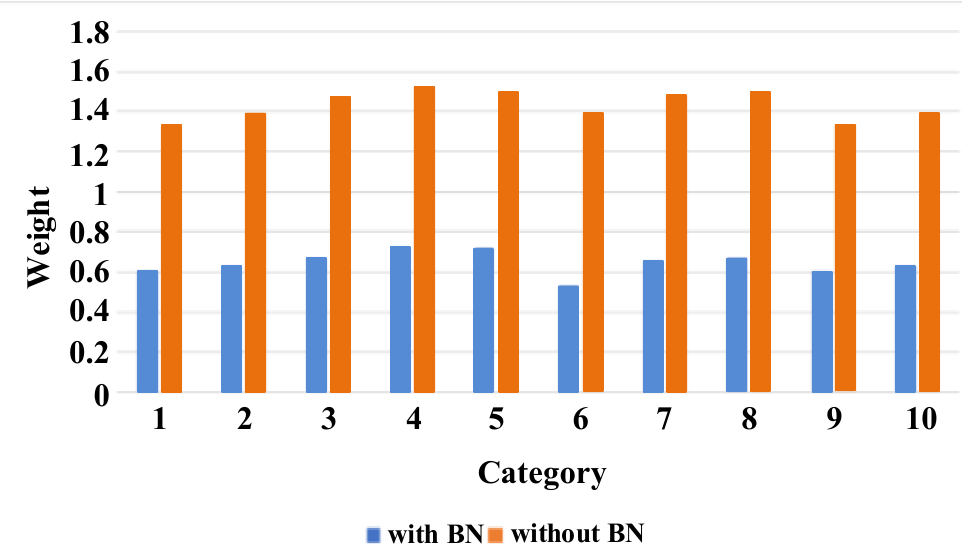
Figure 3. Modulus comparison of the first ten classes of linear layer corresponding to weights.